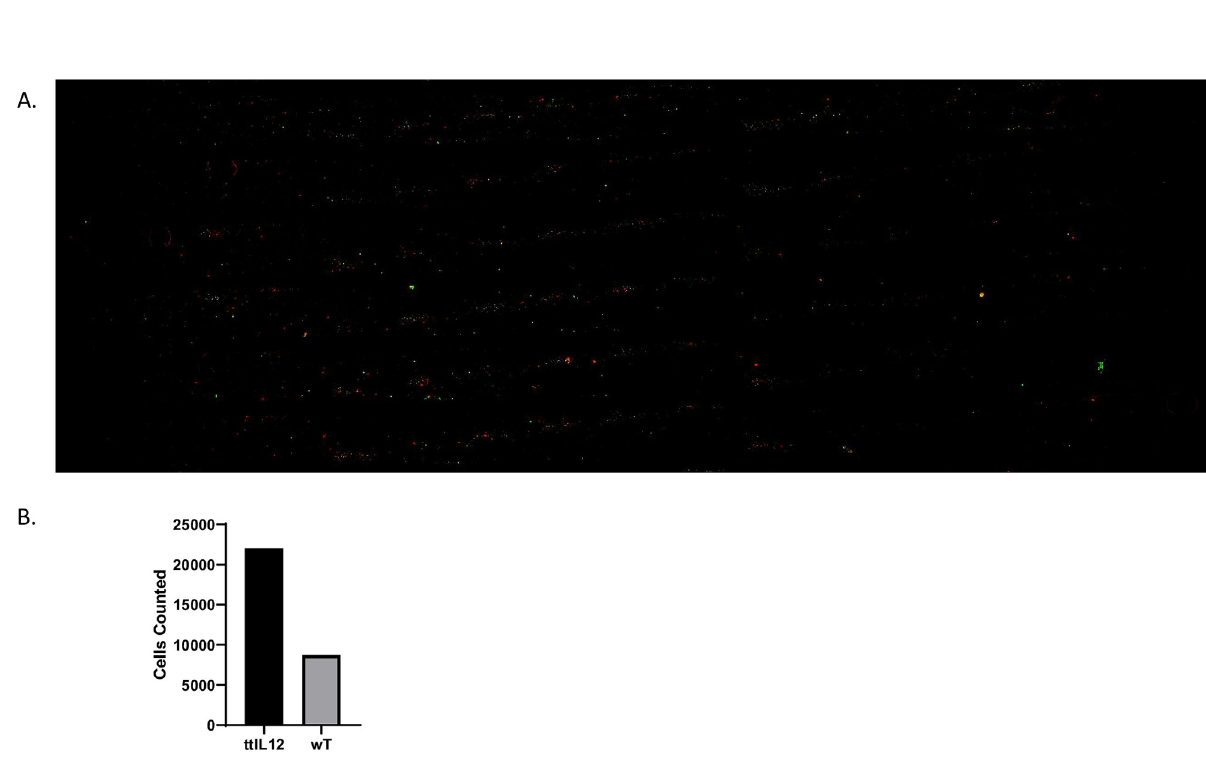
Fig 3. The Cytoquest is capable of isolating ttIL12 T cells from wt T cells based on Vimentin expression. (A) Fluorescent microscopic imaging of vimentin coated slide chip after being loaded and washed with ttIL12 T Cells (red) and wt T Cells (green) (B) Quantification of cells.